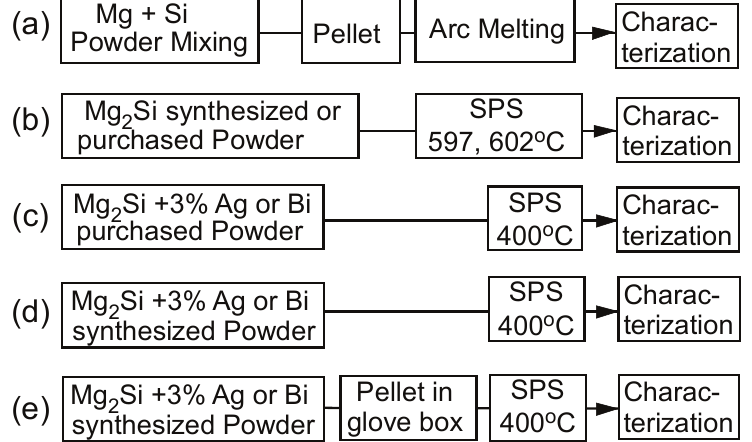
Figure 1. XRD pattern of synthesized Mg